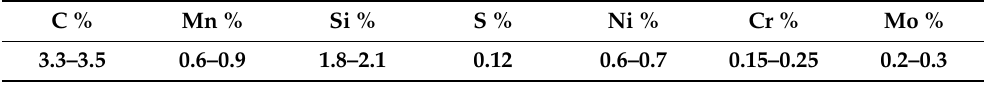
Table 3. Composition of the